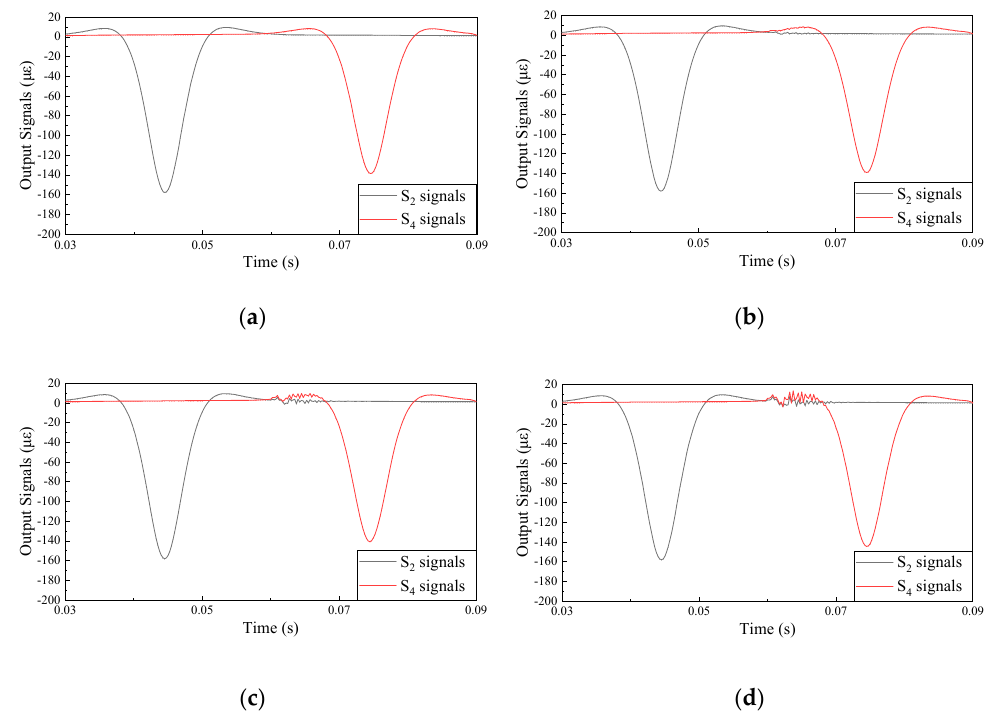
Figure 13. Output signals of Plan II under its most unfavorable condition: ( a ) Without wheel flat; ( b ) wheel flat depth of 0.1 mm; ( c ) wheel flat depth of 0.3 mm; and ( d ) wheel flat depth of 0.5 mm.